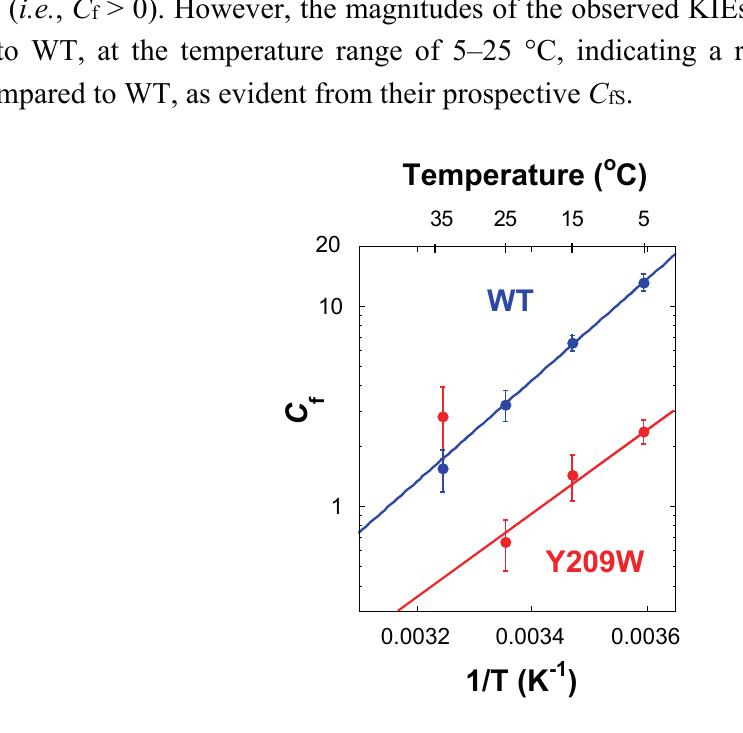
Figure 7. Comparison of commitment to catalysis ( C f ) on the V / K of proton abstraction for WT [16] (blue) and Y209W (red) ec TSase. The lines represent the exponential fit to all data points excluding Y209W at 35